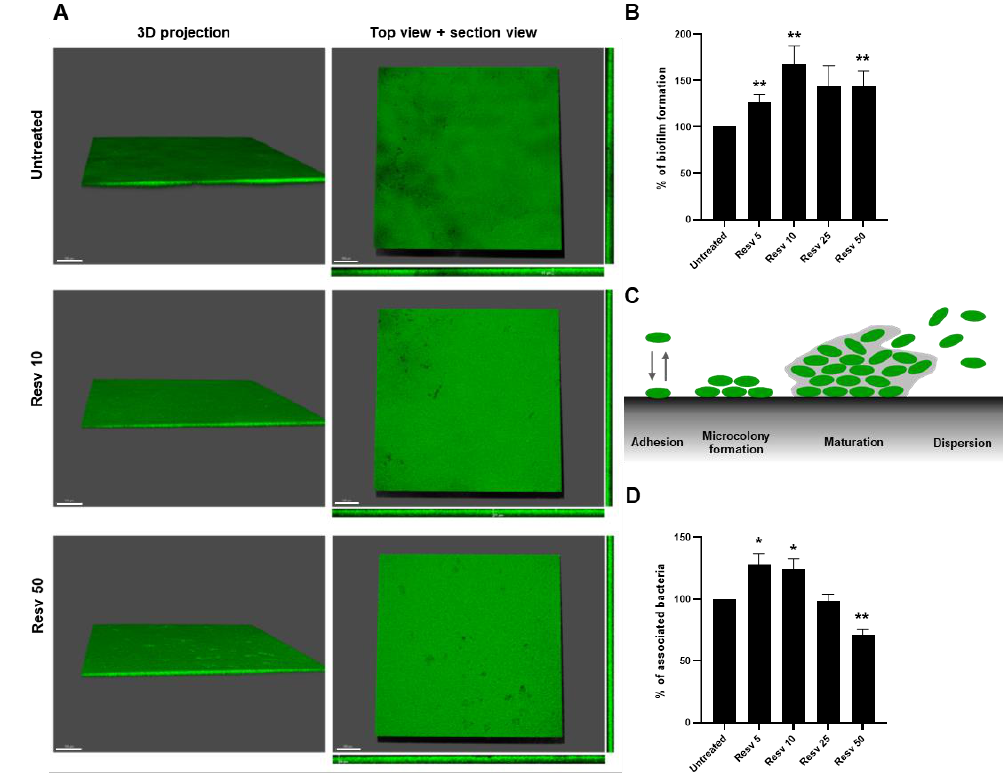
Figure 2. Resveratrol increased the biofilm formation by L. paracasei ATCC334 by enhancing